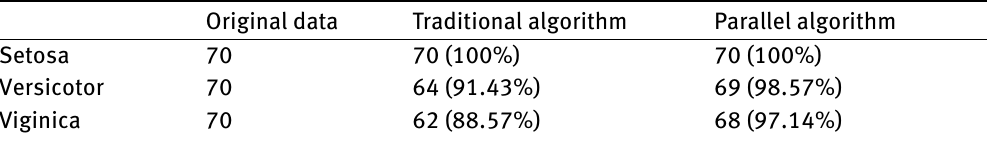
Table 2: Comparison of clustering